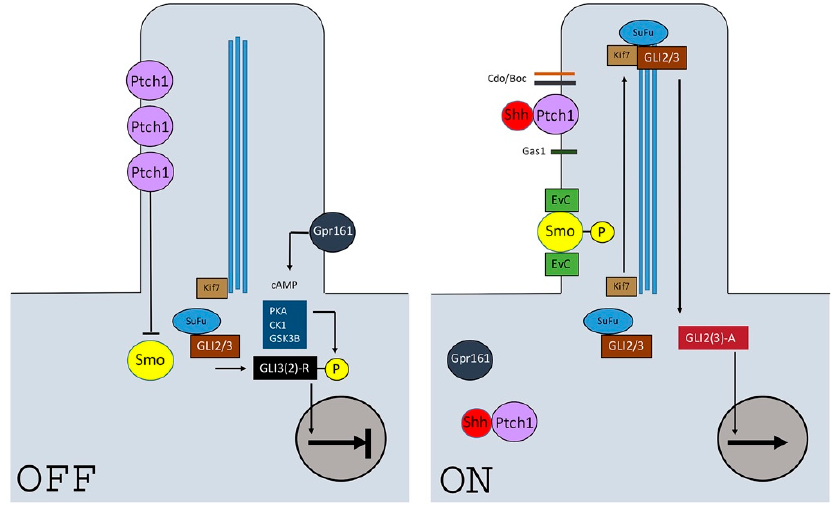
Figure 2. A simple diagrammatic representation of the (known) key events in Shh signaling at the primary cilium. In the absence of signal (OFF), Ptch1 accumulates at the ciliary membrane and represses Smo. GLI proteins are sequestered by Kif7 and Suppressor-of-fused (SuFu), and phosphorylated through the activity of Gpr161, PKA, CK1 and GSK3B. The phosphorylated GLI proteins are proteolytically processed into truncated repressor forms, which act to inhibit transcriptional activation of the pathway. The signaling pathway is activated (ON) through the binding of Shh to Ptch1, which is facilitated by Cdo, Boc and Gas1 co-receptors. The receptor complex is internalized and degraded, which leads to the accumulation of Smo in the ciliary membrane, where it is phosphorylated and interacts with Ellis-van Creveld (EvC) proteins in the basal component of the cilium. The Kif7, SuFu, and GLI complex moves to the tip of the cilium where GLI is concentrated and then transported back to the cytosol where it enters the nucleus as a full length activator of transcriptional targets.